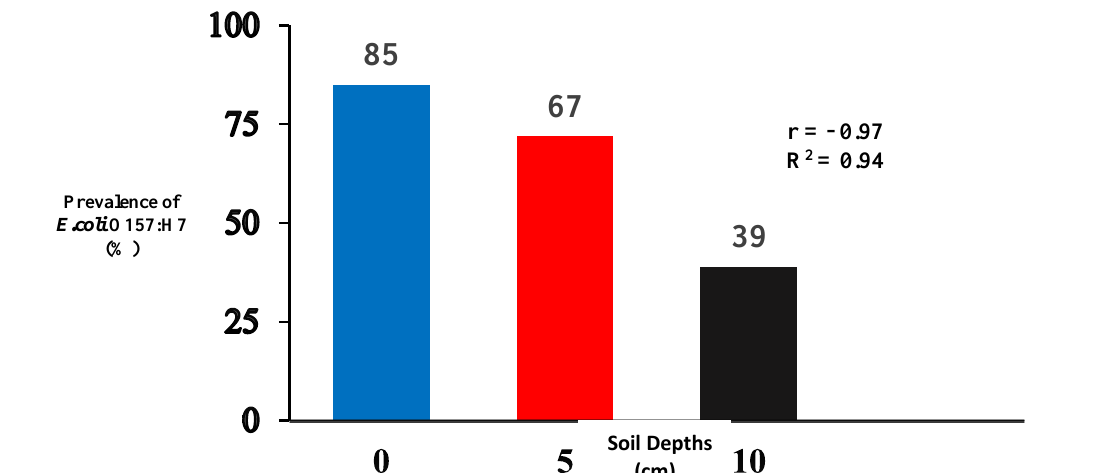
Figure, 1: Overall Prevalence of E.coli O157:H7 from the soil at different depths (0, 5, and 10 cm) irrespective of the directions and